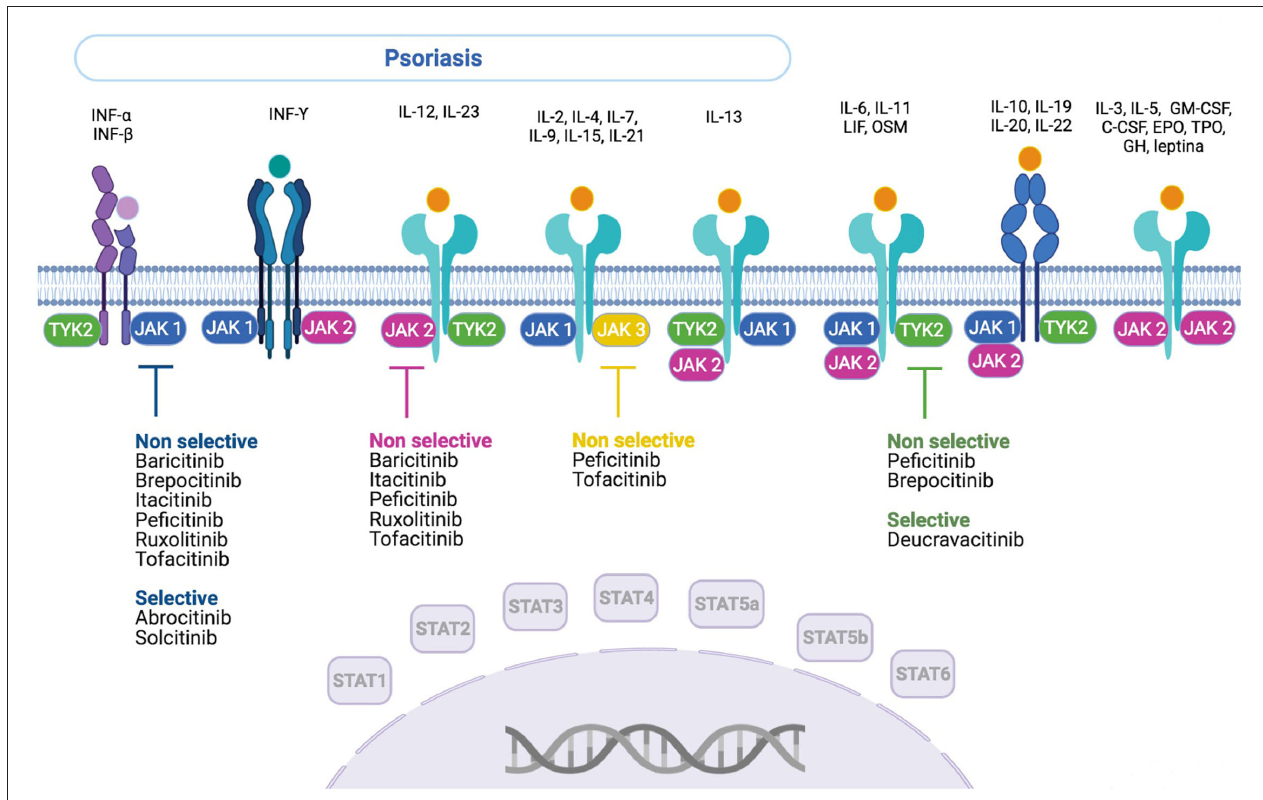
FIGURE 2 | Anti-JAK drugs—action mechanism and selectivity. INF, interferon; IL, interleukin; OSM, oncostatin M; LIF, leukemia inhibitory factor; GM-CSF, granulocyte-macrophage colony-stimulating factor; C-CSF, granulocyte colony-stimulating factor; EPO, erythropoietin; TPO, thrombopoietin; GH, growth hormone.